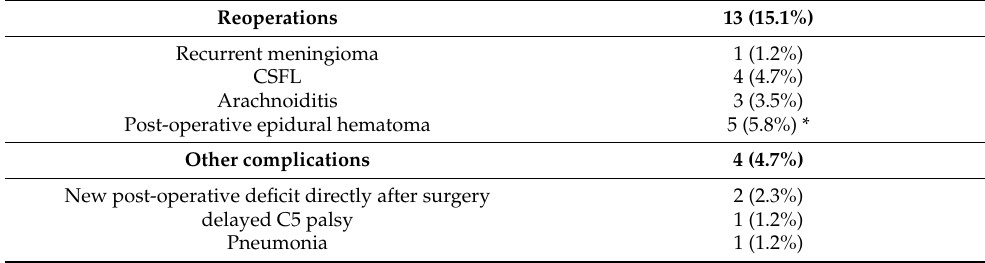
Table 3. Complications and